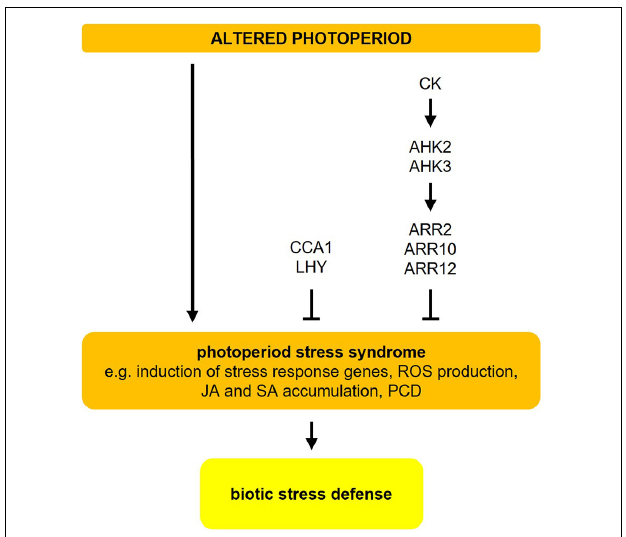
FIGURE 4 | Photoperiod stress in Arabidopsis . Changes in the photoperiod, i.e., prolongation of the light period, result in a photoperiod stress syndrome, which is characterized by induction of stress response genes, ROS production, accumulation of jasmonic acid (JA) and salicylic acid (SA), and eventually programmed cell death (PCD). Both, cytokinin (CK) (mostly trans -zeatin) and CCA1/LHY are negative regulators of photoperiod stress. Photoperiod stress elicits a transcriptional response that resembles the response to ozone stress and pathogen infection. The resistance to an infection with P. syringae pv. tomato DC3000 is increased after a preceding photoperiod stress event. For more detailed information about the different pathways, please refer to sections “Changes in the Photoperiod Cause Stress” and “Photoperiod Stress Elicits a Similar Response as Pathogen Infection.” The figure has been adapted from Roeber et al.